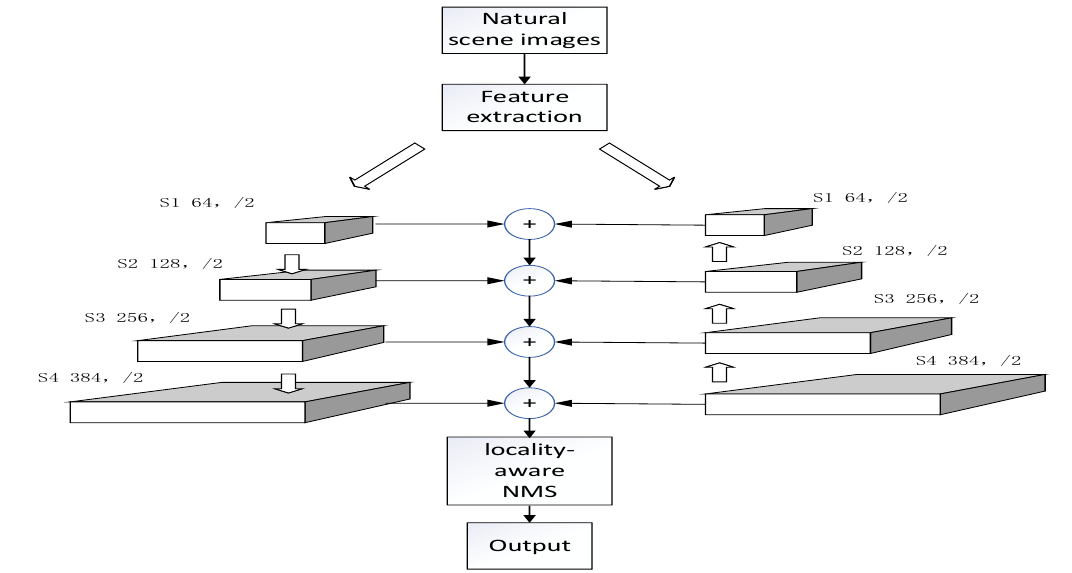
Figure 2. Schematic diagram of the original hybrid feature pyramid construction.